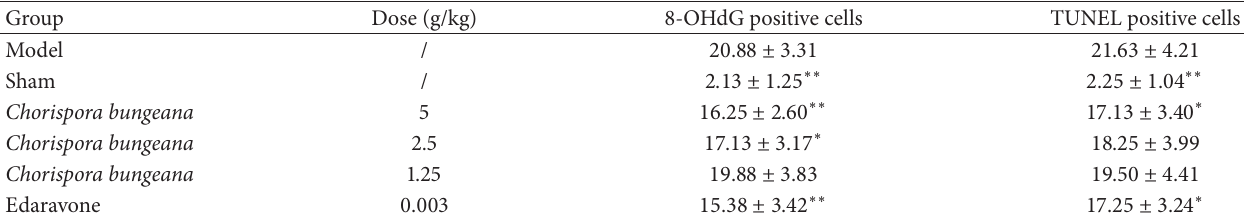
Table 2: Effect of Chorispora bungeana water extract on 8-OHdG expression and cell apoptosis in mice subjected to cerebral ischemia/reperfusion.